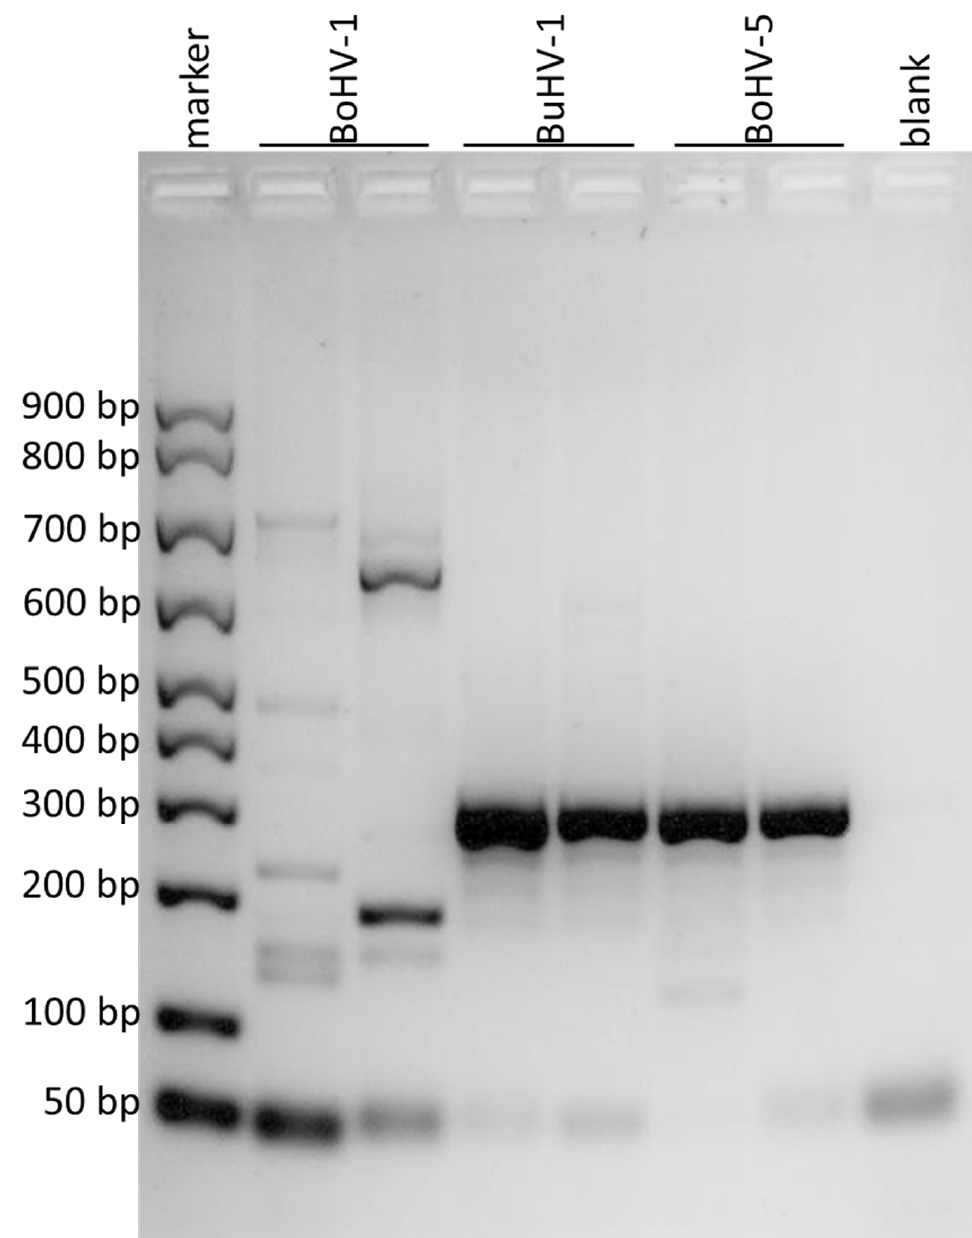
Figure 3. Agarose gel electrophoresis of the amplified products obtained by using the primers for the portion of gE gene. The DNA marker in the first lane showed the first band at 50 bp, the second at 100 bp and the subsequent ones at 100 bp from each other. BoHV-1 was loaded in the second and third lanes, BuHV-1 in the fourth and fifth, BoHV-5 in the sixth and in the seventh and the eighth lane was the negative control (blank). Amplification products of 295 bp were observed for BuHV-1 and BoHV-5 .